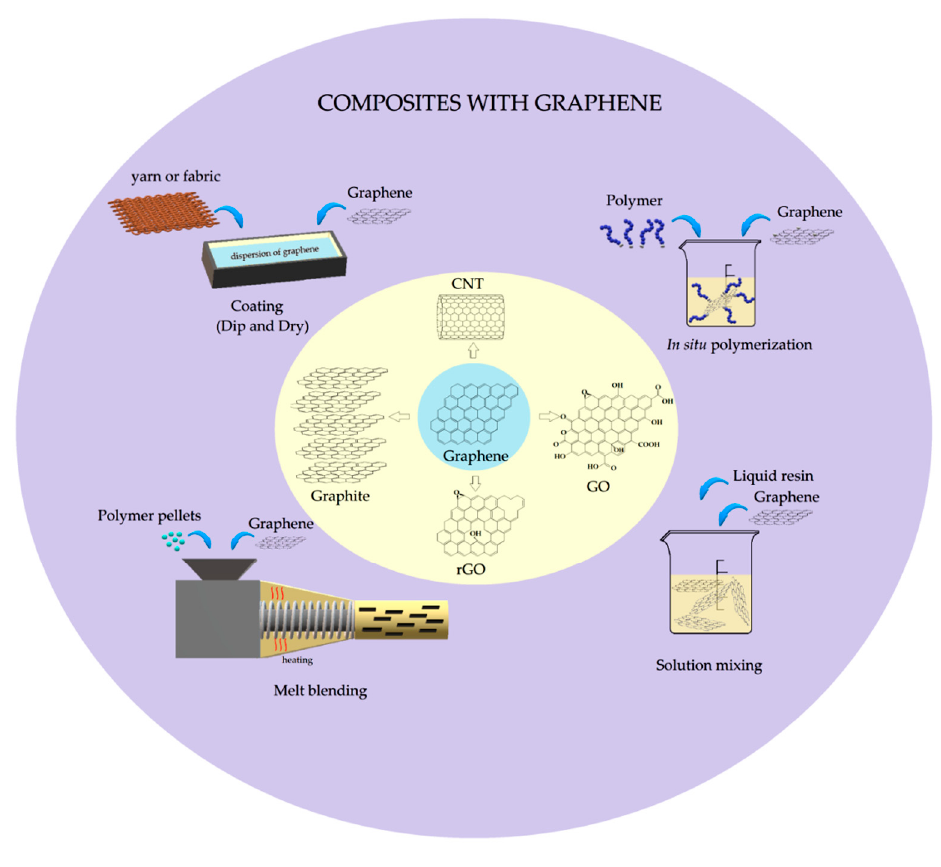
Figure 2. A schematic summarizing the main manufacturing processes and graphene-based materials used in composites.